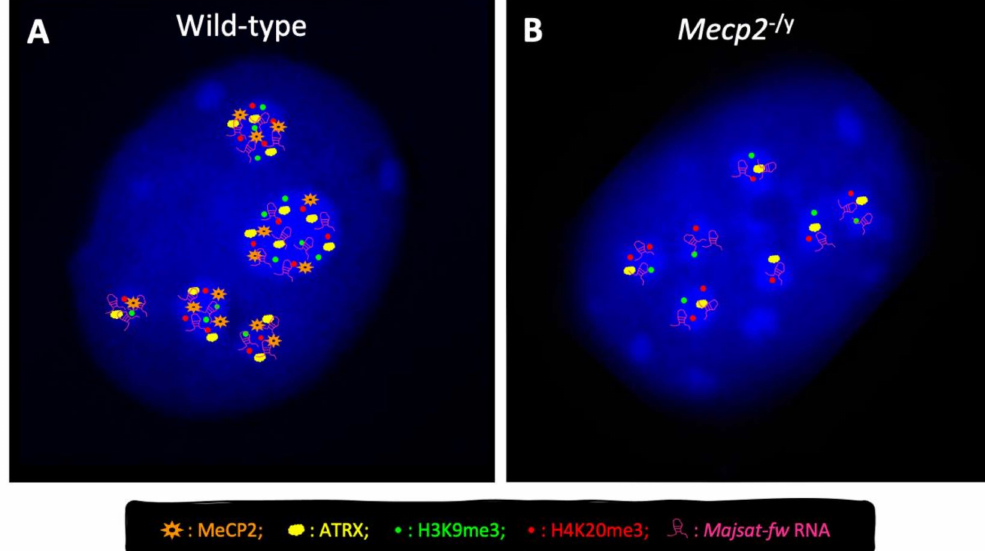
Figure 3. Schematic representation of pericentric heterochromatin organization in nuclei of wild-type and Mecp2 − /y neurons derived from differentiation of murine embryonic stem cells. Representative images of interphase wild-type (WT) ( A ) and Mecp2 − /y ( B ) nuclei were depicted. Chromocenters are highlighted by intense 4 (cid:48) ,6-diamidino-2-phenylindole (DAPI) staining (blue). In terminally differentiated Mecp2 − /y cells ( B ), the number of chromocenters is higher and their size is lower in comparison with WT cells ( A ), due to the role of MeCP2 in the pericentric heterochromatin condensation (chromocenter clustering) during neural differentiation [60]. Moreover, MeCP2 contributes to the targeting of ATRX [59] and MajSat-fw transcript to chromocenters and preserves the correct deposition of H3K9me3 and H4K20me3 histone marks to pericentric heterochromatin